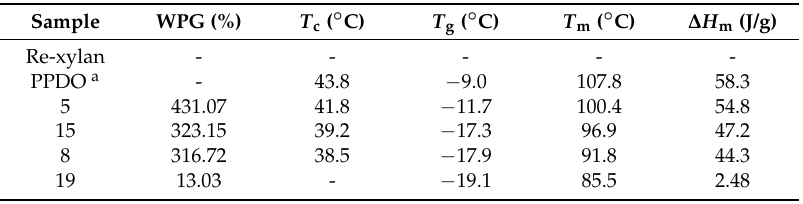
Table 2. Data obtained from DSC curves of regenerated xylan and xylan- g -PPDO copolymers with various WPG.